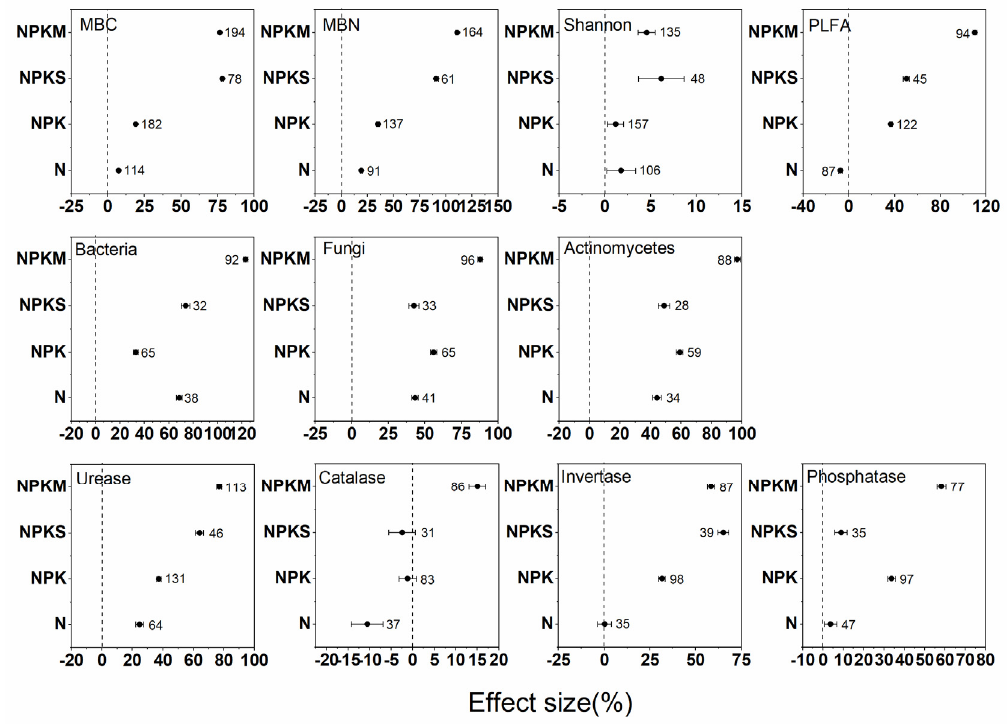
Figure 3. The effect size of fertilization on MBC, MBN, Shannon index, PLFA, bacteria, fungi, Actinomycetes , urease, catalase, invertase and phosphatase depending on four main fertilizer regimes, i.e., N, NPK, NPKS, NKPM. The numbers approximating the black dots are the data numbers. MBC: microbial biomass carbon; MBN: microbial biomass nitrogen; PLFA: phospholipid fatty acid; N: sole nitrogen fertilizer; NPK: the phosphorus, potassium, and nitrogen fertilizer; NPKS: NPK combined with straw; NPKM: NPK combined with manure.